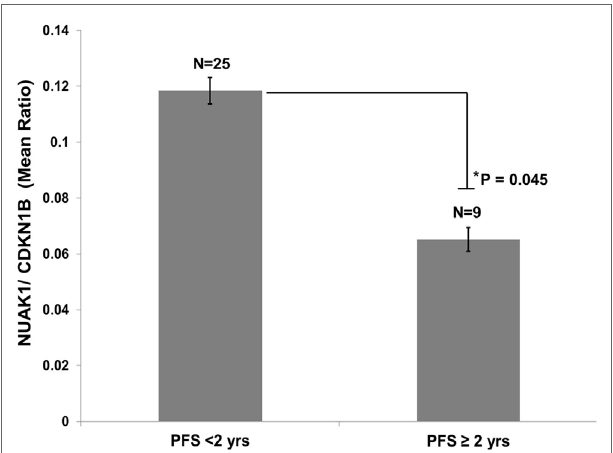
FigUre 2 | elevated nUaK1 transcript expression is associated with poor progression-free survival in an independent cohort of high-grade serous ovarian cancer patients . Quantitative PCR analyses of formalin-fixed, paraffin-embedded tissues from advanced stage serous ovarian cancer patients exhibiting less than 2 years versus greater than or equal to 2 years progression-free survival (Student’s t -test p = 0.045). Data reflects triplicate, technical replicate